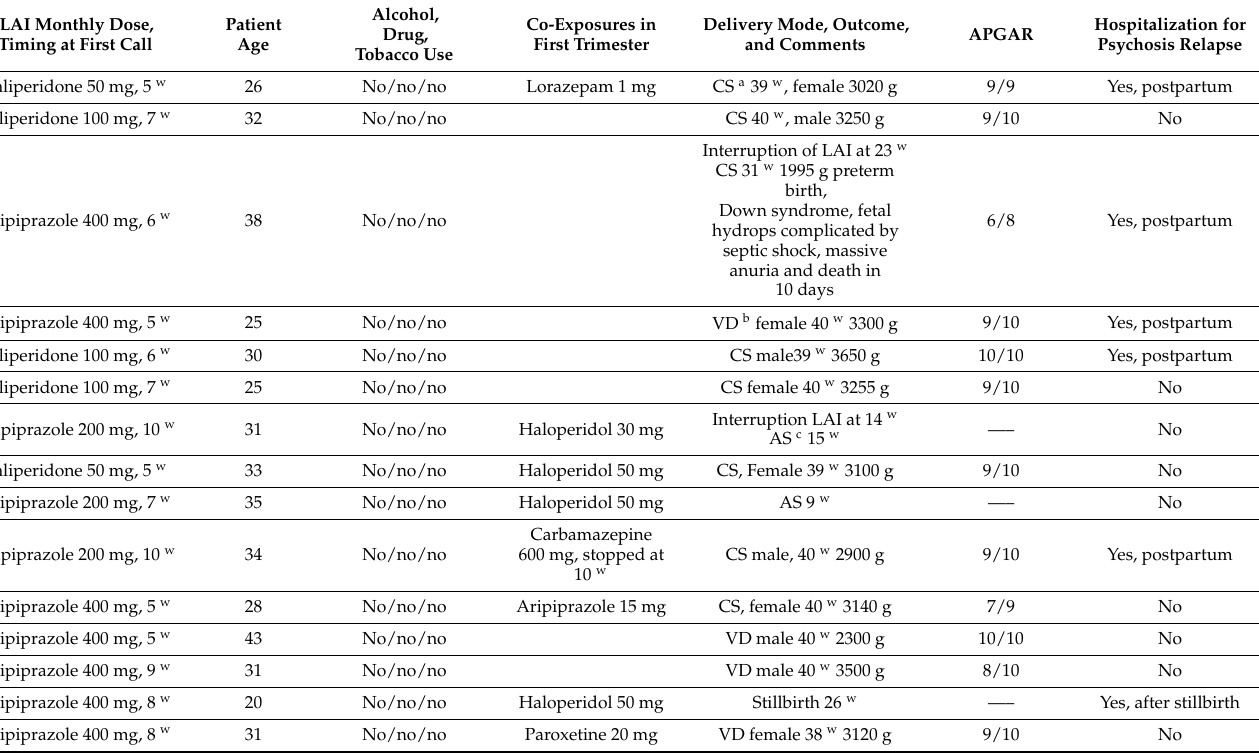
Table 1. Detailed description of the